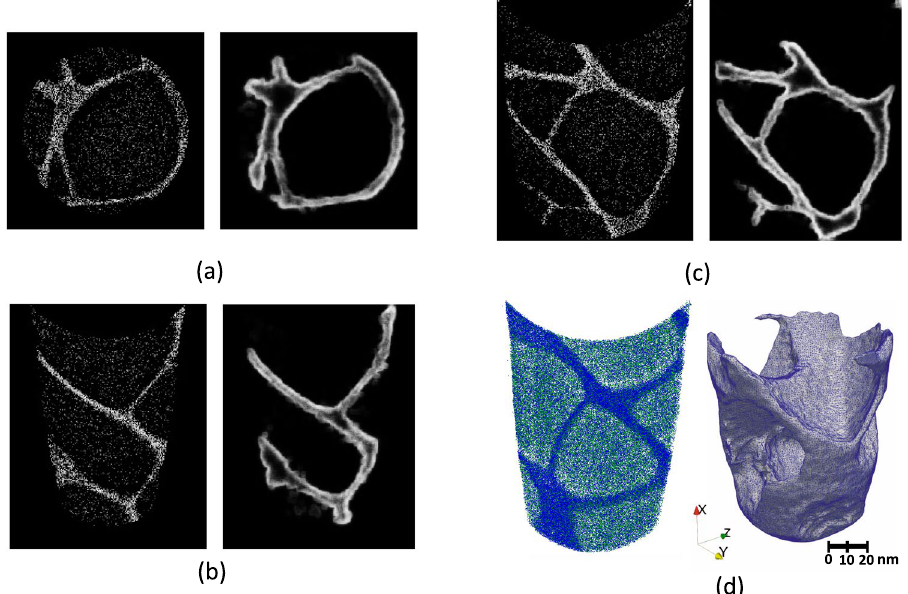
Figure 4. Two- and three-dimensional edge detection map of the experimentally obtained APT data set from a Co-based superalloy. ( a ) Concentration space (left) and edge detection map (right) of a slice along the X-direction, ( b ) Concentration space (left) and edge detection map (right) of a slice along the Y-direction, ( c ) Concentration space (left) and edge detection map (right) of a slice along the Z-direction, ( d ) Three-dimensional point cloud reconstruction of the entire Co superalloy APT specimen (left) and the resulting interface from the edge detection method (right). This method identifies the interconnected γ matrix channels on the order of tens of nm.